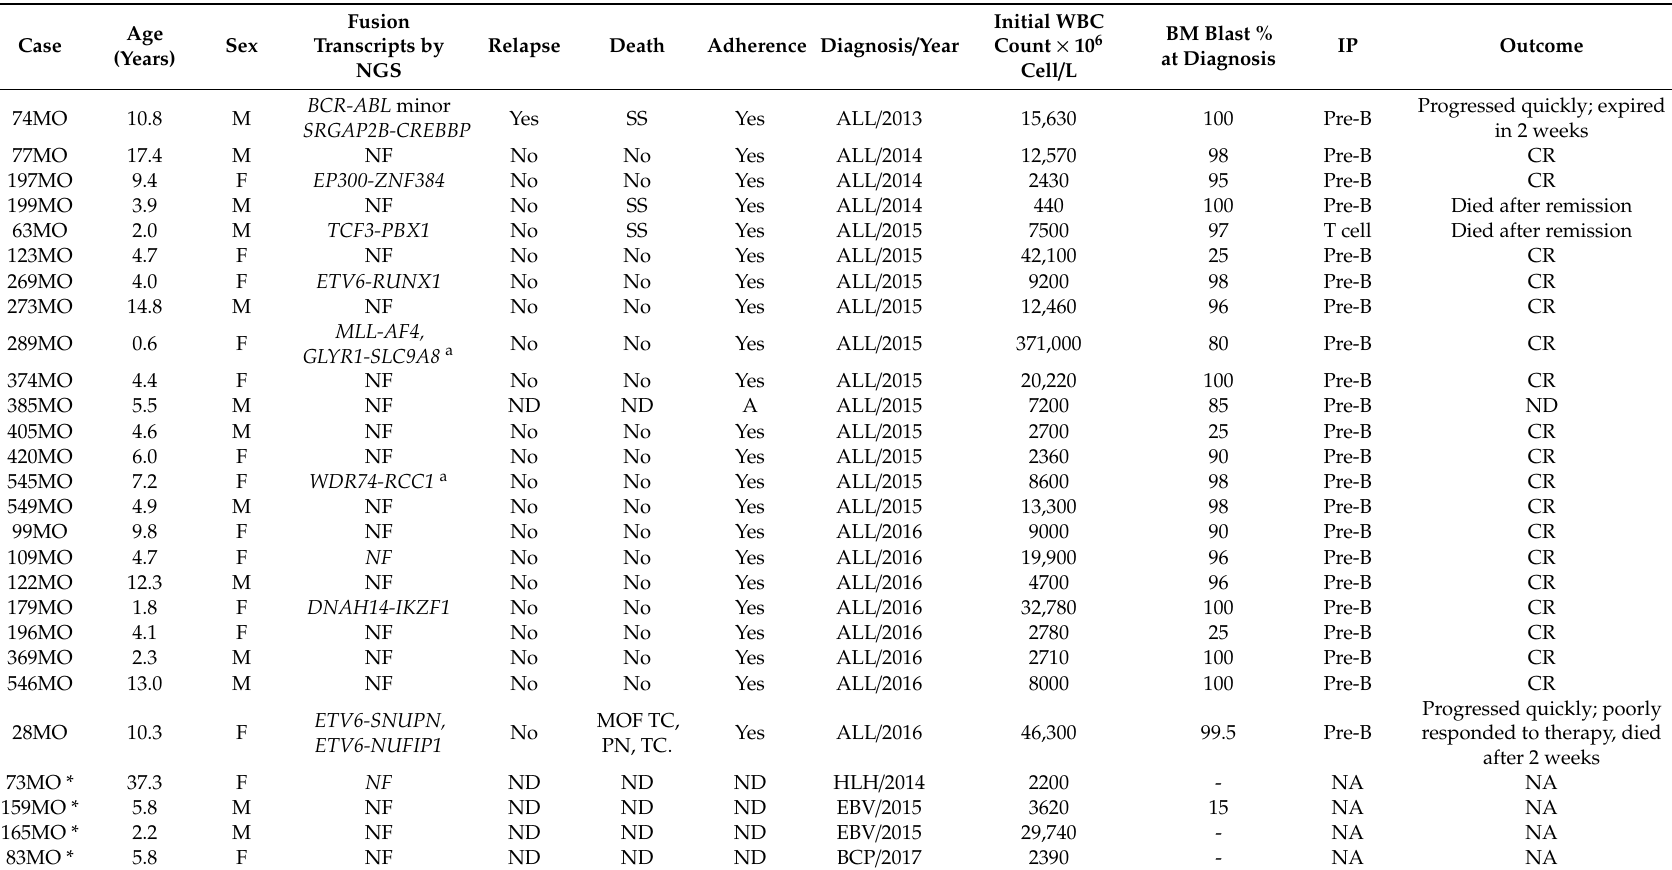
Table 1. Clinical characteristics and fusion gene present in patients with acute lymphoblastic